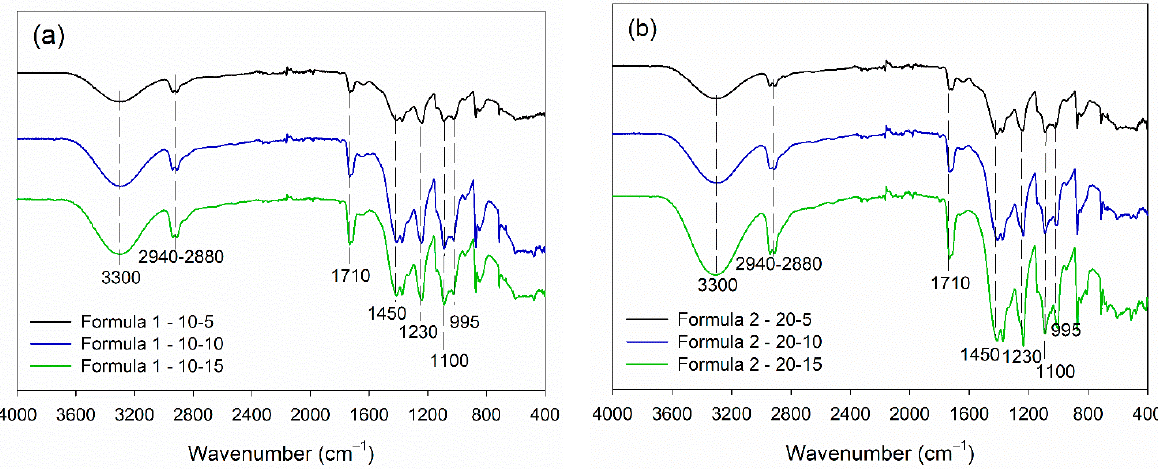
Figure 4. FTIR spectra of PVOH–tannin–hexamine-based adhesives. ( a ) Formula 1, ( b ) Formula 2.